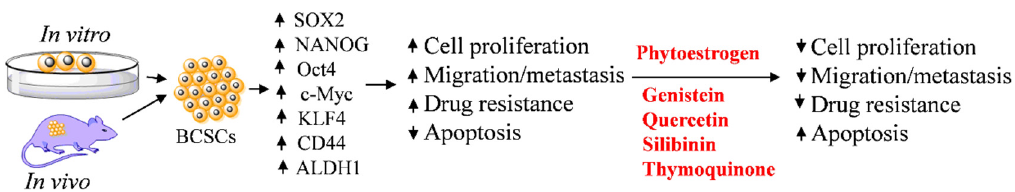
Figure 3. Effect of phytoestrogen(s) on the luminal A-derived mammosphere. ALDH1—Aldehyde dehydrogenase 1, Krüppel-like factor 4, and BCSCs—Breast cancer stem cells. dehydrogenase 1, Krüppel-like factor 4, and BCSCs—Breast cancer stem